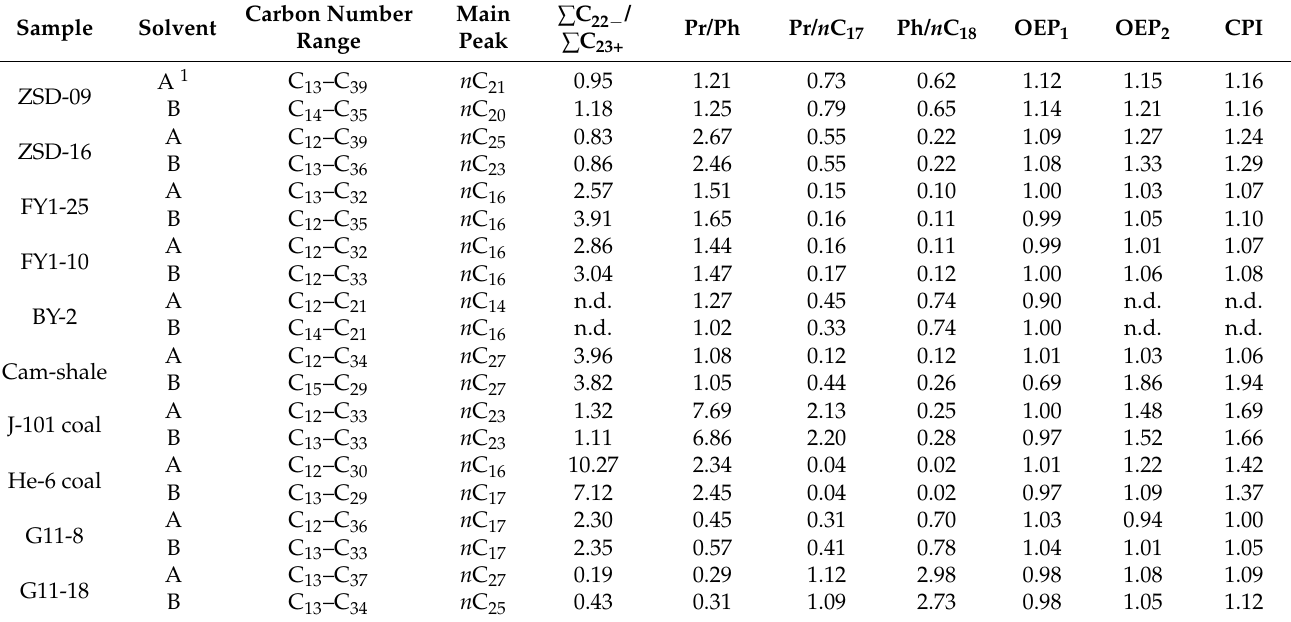
Table 2. Biomarker parameters for saturated hydrocarbons from TCM and DCM: MeOH